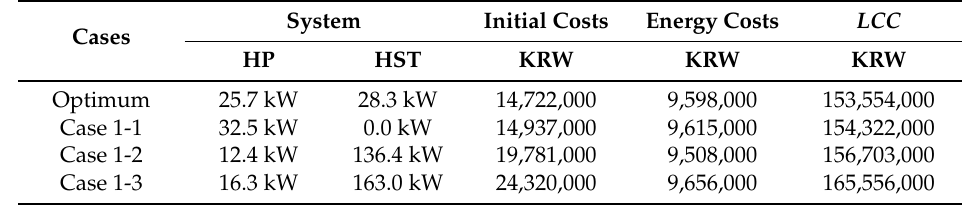
Table 9. The feasibility assessment compared with conventional cases.